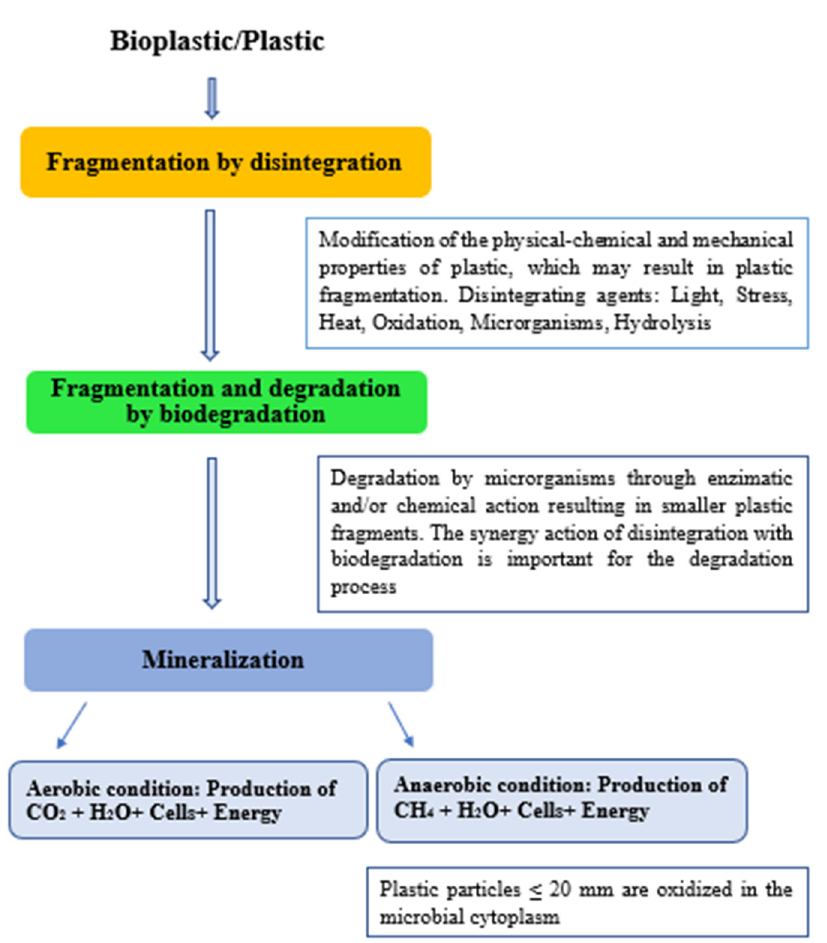
Figure 3. Disintegration, biodegradation, and mineralization process of plastic polymeric materials. Adapted [47].